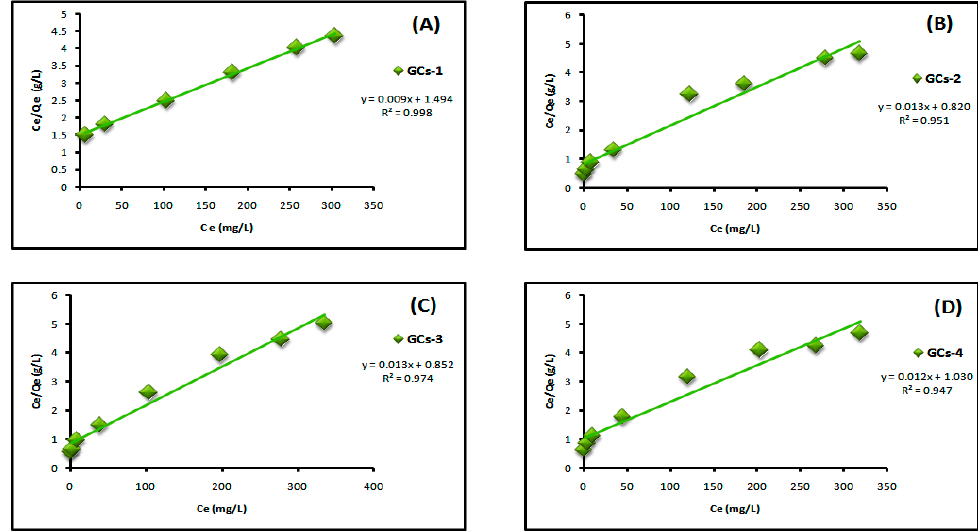
Figure 7. Langmuir isotherm for Ni(II) adsorption using ( A ) GCs-1; ( B ) GCs-2; ( C ) GCs-3 and ( D ) GCs-4.